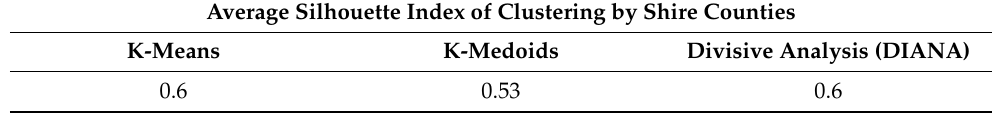
Table 7. Comparison of clustering algorithms for shire county analysis.